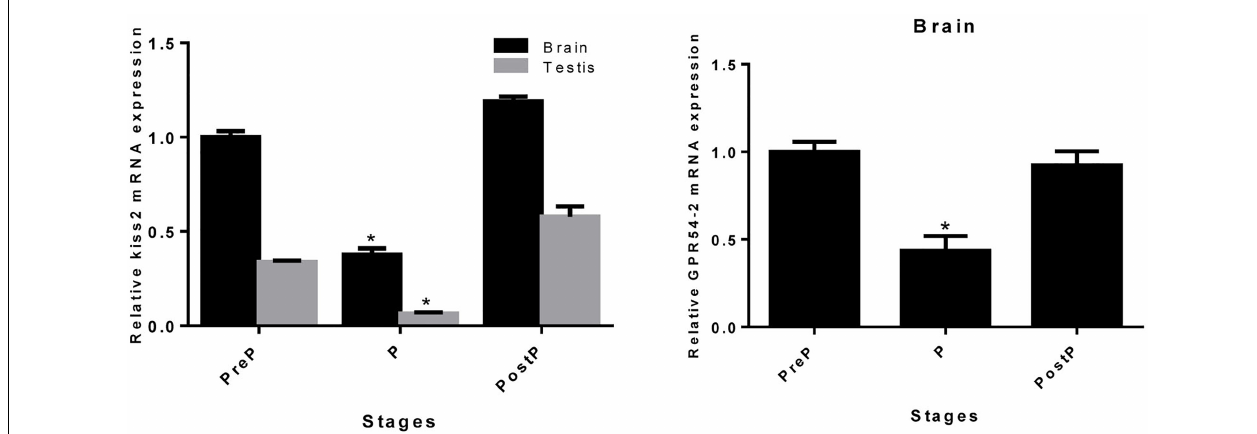
FIGURE 7 | The mRNA expressions of kiss2 in the brain and testis ( n = 8) and GPR54-2 in the brain of the male seahorses during different pregnant stages. PreP, pre-pregnant stage; P, pregnant stage; PostP, post parturition stage. The mRNA expression levels were identified by real-time PCR normalized against the β -actin transcript and presented as means ± SEM. Asterisks denote significant differences between different stages ( P < 0.05).